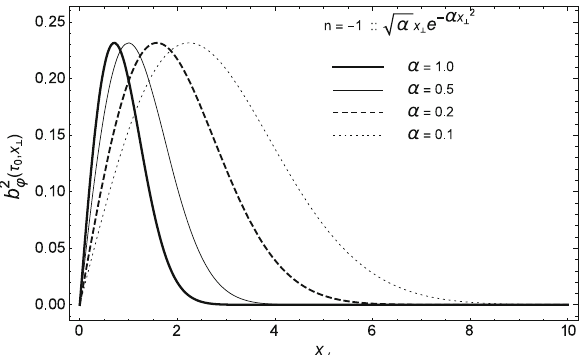
Fig. 9 b 2 φ (τ, x ⊥ ) as a function of x ⊥ for different values of α at τ 0 = 1 fm